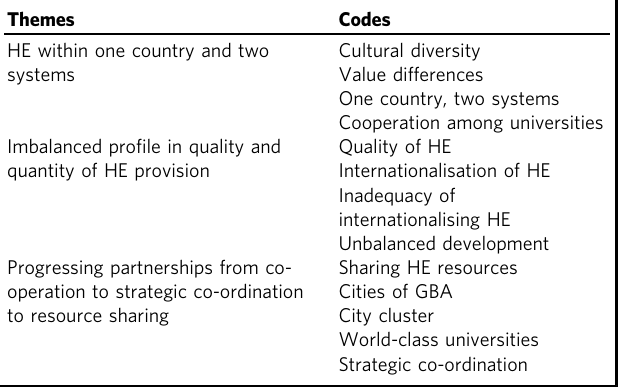
Table 3 Themes and codes de fi ned from the